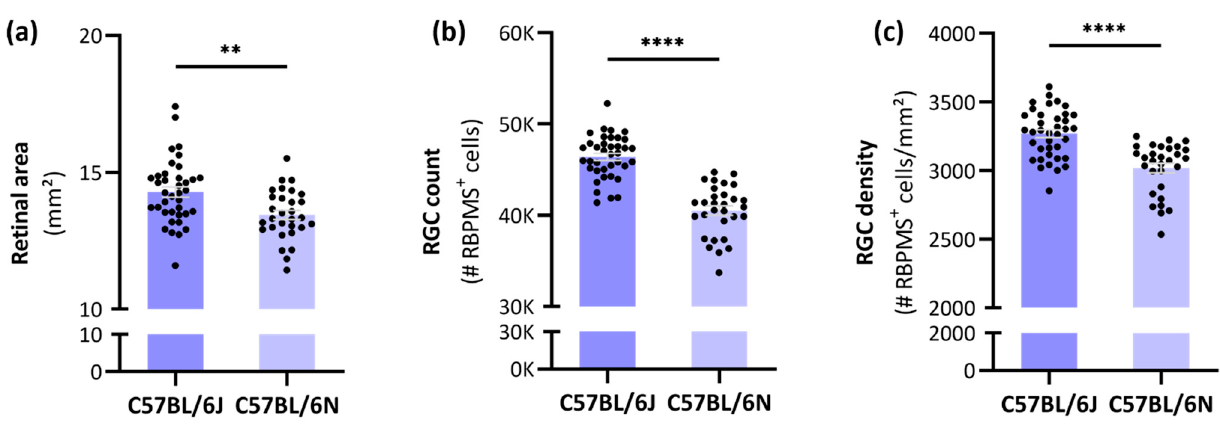
Figure 1. Retinal area, total RGC count and global RGC density across C57BL/6J and -N substrains. The total retinal area ( a ); RGC number ( b ); and RGC densities ( c ) of these C57BL/6 substrains followed a normal distribution (D’Agostino & Pearson test, α = 0.05). The average retinal area, RGC number and -density of C57BL/6N ( n = 30) mice was significantly lower compared to C57BL/6J mice ( n = 38). Unpaired, two-tailed t-test; ** = p ≤ 0.01; **** = p ≤ 0.0001. Automated segmentation and RBPMS + RGC countings were achieved via the freely available software RGCode on entire retinal wholemounts [14].